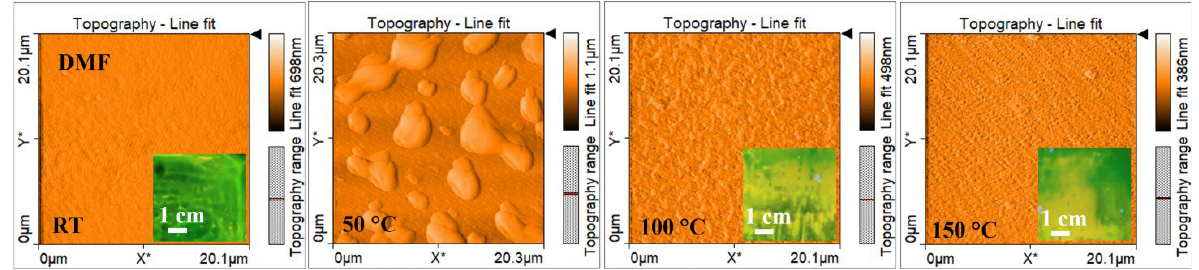
Figure 2. Representative AFM image for films deposited with DMF as solvent. The inset is pictures of the films under UV light.